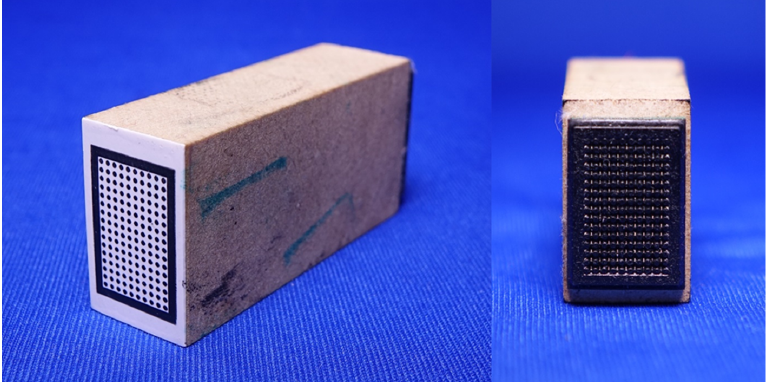
Figure 5. Overview of the experimental setup. By filling the water tank with oil, the texture is LED is attached to reduce the noise from the high-speed camera.